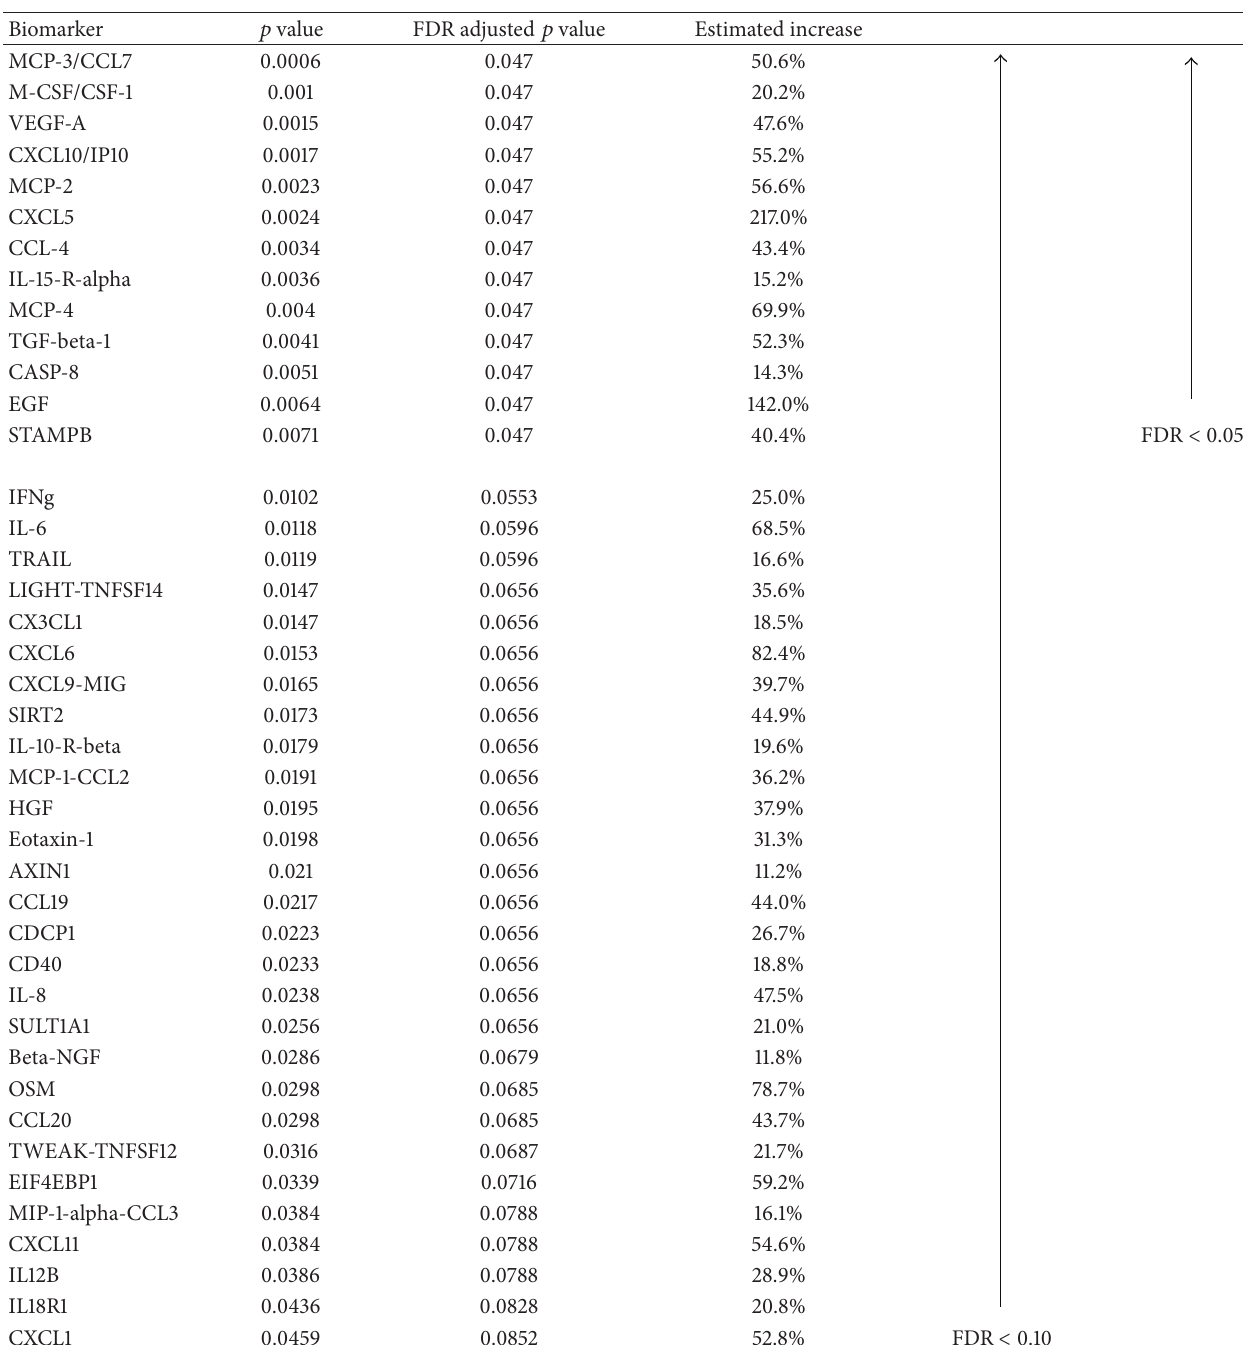
Table 2: List of biomarkers which are significantly differentially expressed when the false discovery rate (FDR) is 0.10 and 0.05. The rightmost column shows the estimated increase on the original non-log